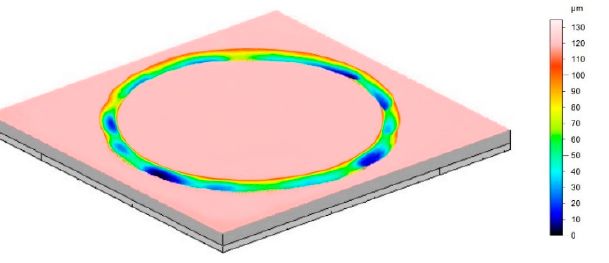
Figure 10. Corrugation wear on non-oxidized Ti-6Al-7Nb alloy disc, after tribological tests with 100Cr6 bearing steel balls.